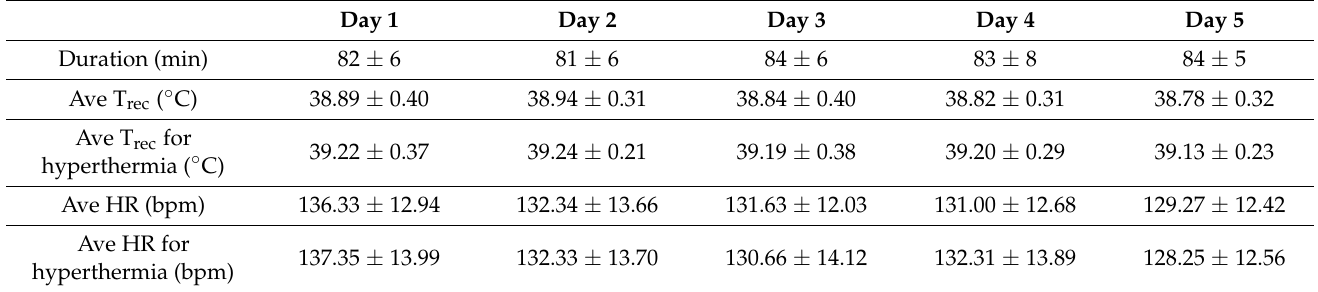
Table 1. The duration, average rectal temperature (T rec ), average T rec for hyperthermia period, average heart rate (HR), and average HR for hyperthermia period during heat acclimation from Day 1 to Day 5.